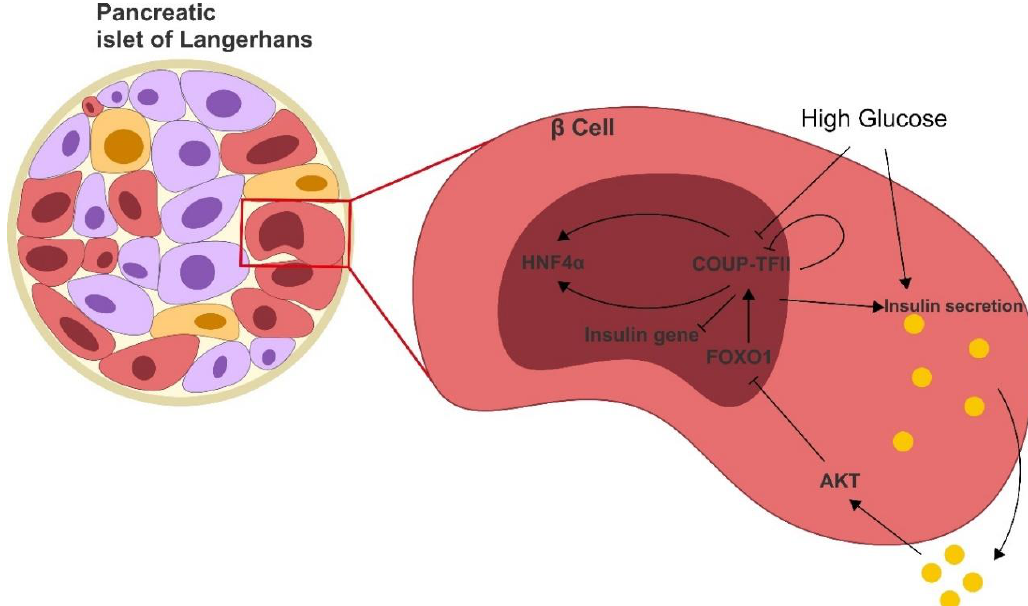
Figure 3. COUP-TFII and insulin in pancreatic β-cells. High glucose concentrations in the blood induce the release of insulin by β-cells and attenuate the expression of COUP-TFII. COUP-TFII is known to repress insulin genes, hence reducing the expression of COUP-TFII increases insulin gene expression but reduces insulin secretion. Interestingly, insulin in a paracrine manner further decreases COUP-TFII expression by nuclear exclusion of FOXO1 caused by AKT-mediated phosphorylation. HNF4α and COUP-TFII are reciprocally induced and sustain insulin secretion. Based on References [69,72–74].